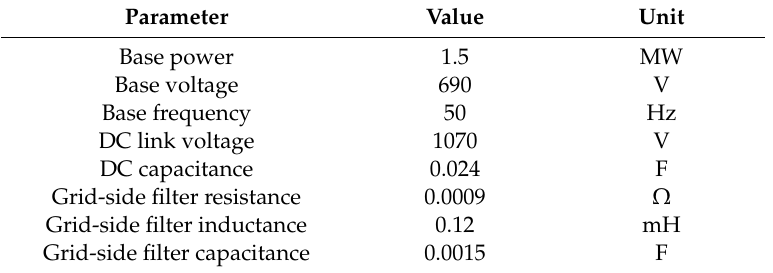
Table A1. Simulation parameters of permanent magnet direct drive wind power system.